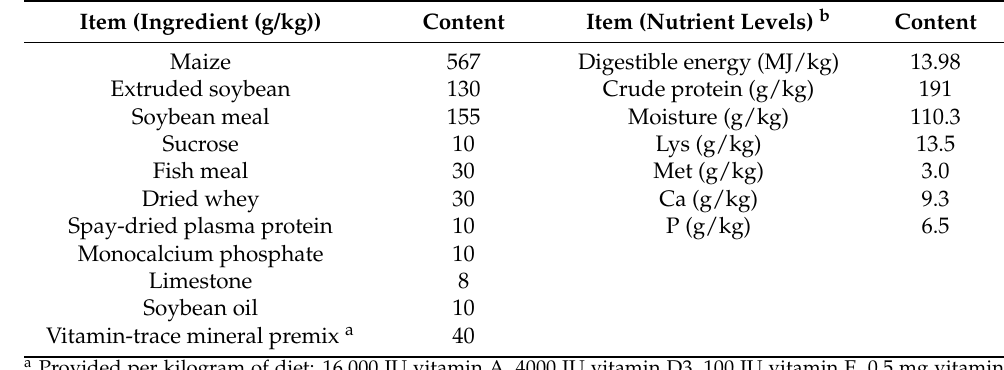
Table 2. Ingredient composition and nutrient levels of the basal diet. Item (Ingredient